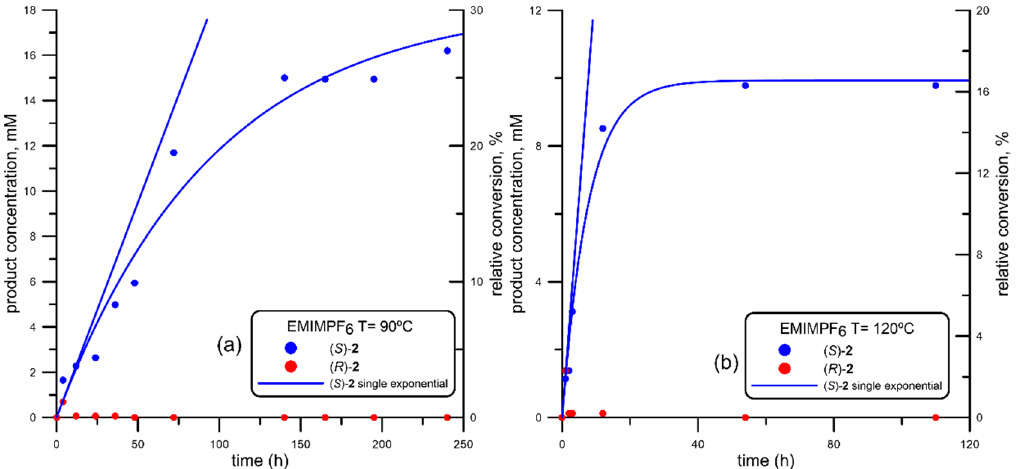
Figure 5. Progress curve of the BTL2-catalyzed production of both enantiomers of mandelic acid (( R )-